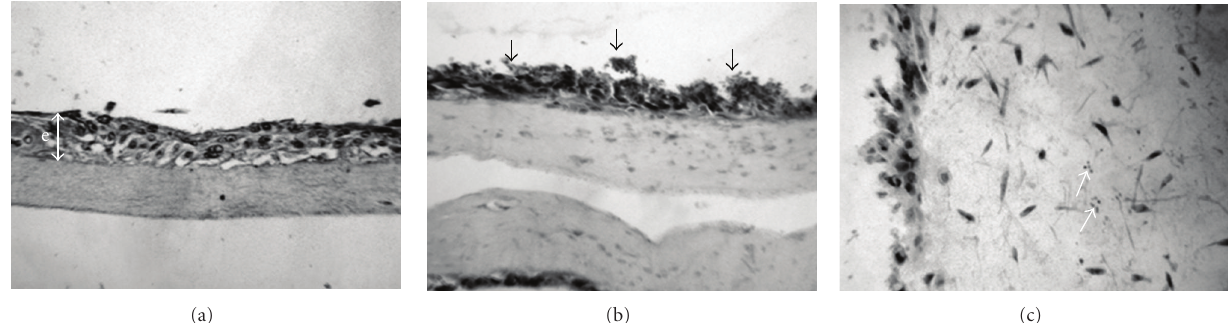
Figure 4: E ff ect of C. parapsilosis on tissue structure and the formation of a biofilm on the engineered human oral mucosa. Histological features of EHOM following exposure to C. parapsilosis . EHOM tissue was infected with (a) no Candida cells (uninfected control) and (b, c) C. parapsilosis strain. Note the formation of a biofilm on the tissue (b) and the presence of C. parapsilosis in the connective tissue (c). Representative photographs of four di ff erent experiments are shown (two EHOMs per experiment). Magnification × 250 for parts (a) and (b), and × 600 for part (c). e: